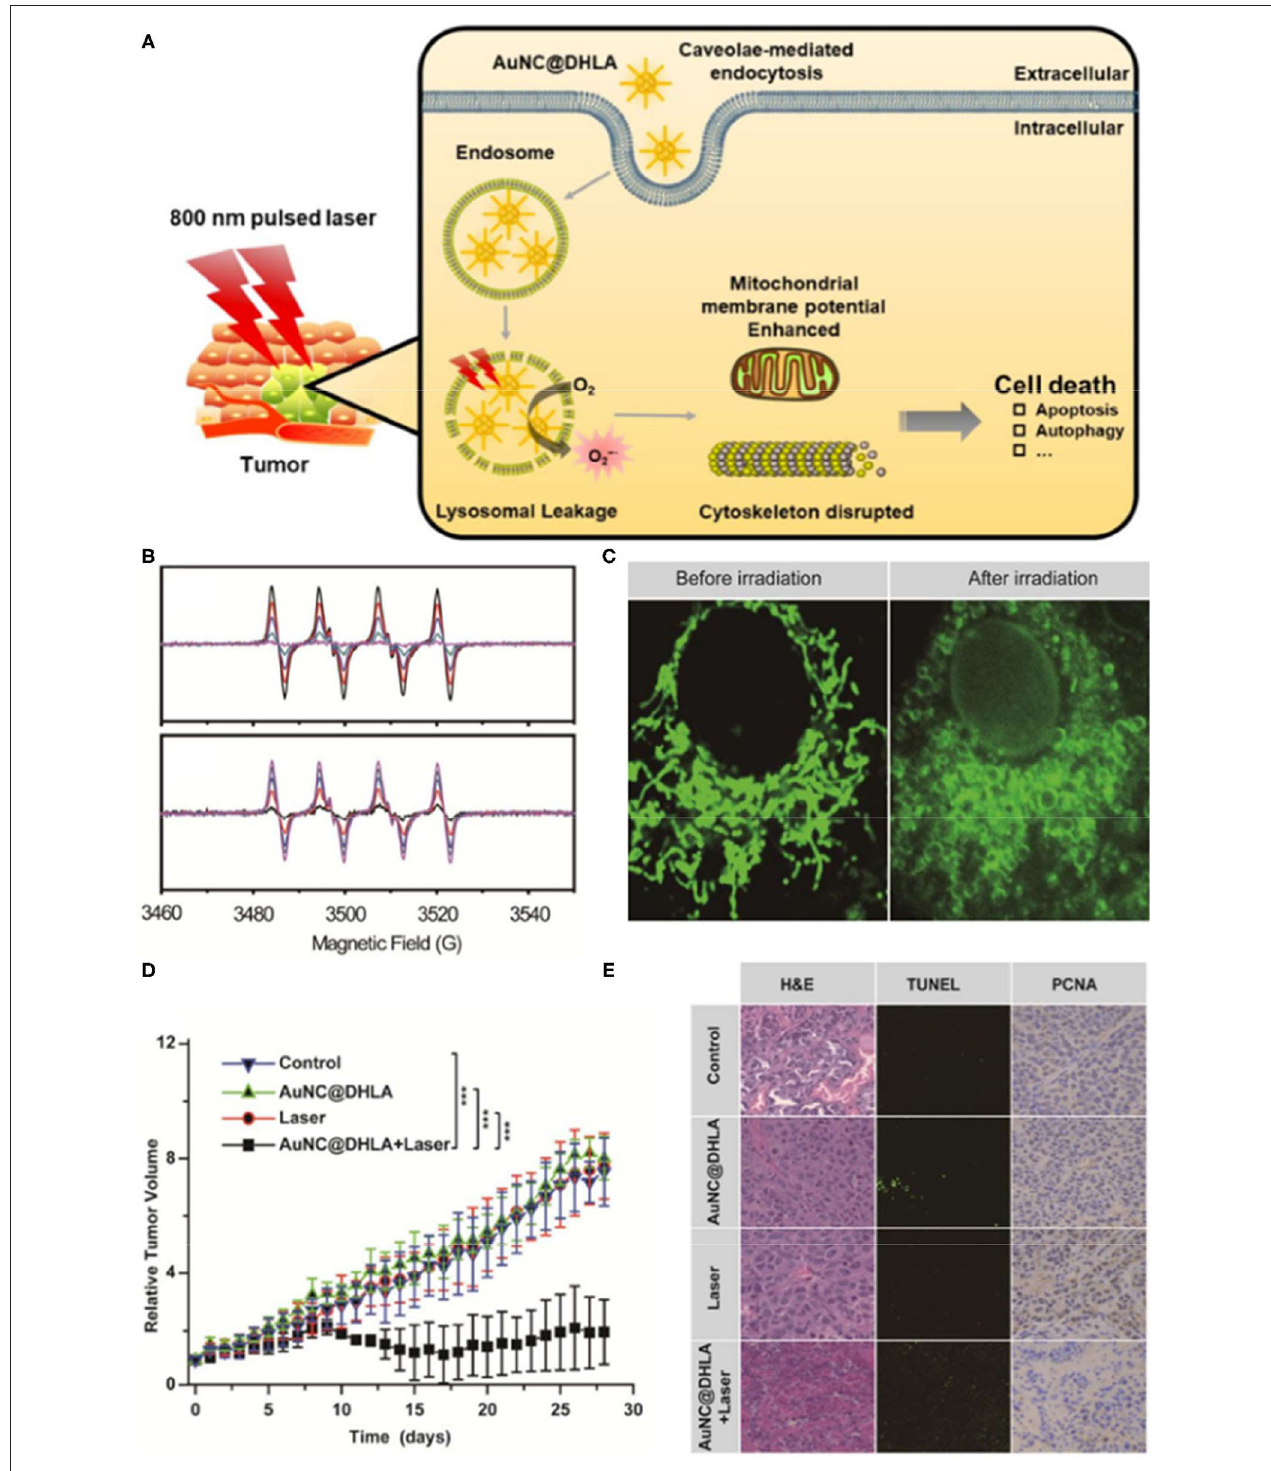
FIGURE 1 | Schematic illustration of the cancer therapy mechanism (A) of dihydrolipoic acid-coated gold nanocluster (AuNC@DHLA) photodynamic therapy (PDT). (B) The Electron spin resonance (ESR) signal of O −• 2 under 488nm light with various power intensities and different laser irradiation durations. (C) Mitochondrial morphology was altered in HepG2 cells before and after irradiation. (D) Tumor growth curve of HepG2 tumor-bearing nude mice in different treatment groups within 28 days. (E) The slices of H&E staining containing liver, kidney, and spleen of tumor-bearing mice treated with phosphate-buffered saline (PBS) and AuNC@DHLA after laser irradiation treatment over a period of 28 days. Reproduced with permission from Han et al. (2020). Copyright (2019) American Chemical Society. *** p < 0.001.